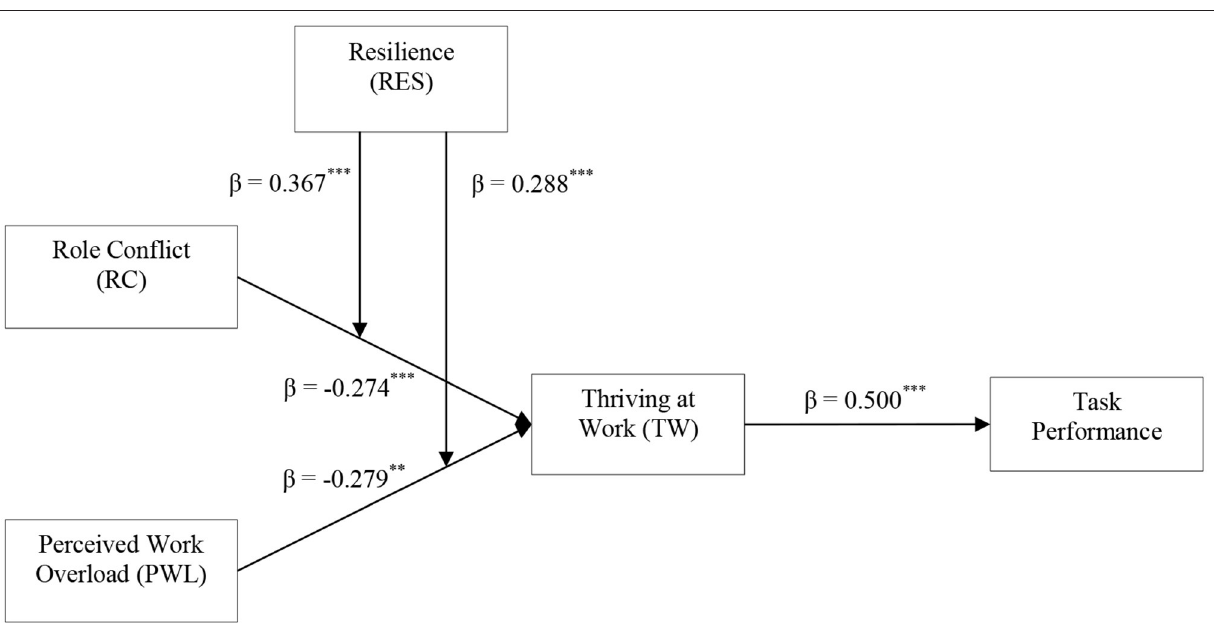
TABLE 1 | Correlation. Variables M SD VIF RC PWL TAW RES TP RC 3.415 0.897 1.330 0.746 PWL 3.182 0.881 1.464 TAW